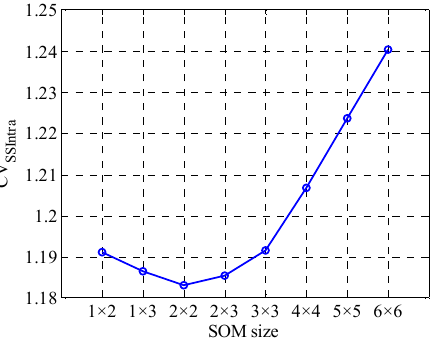
Figure 8. Coefficient variation of intra-class sum of the squared errors (CV SSIntra ) with different self-organizing map (SOM) array sizes.